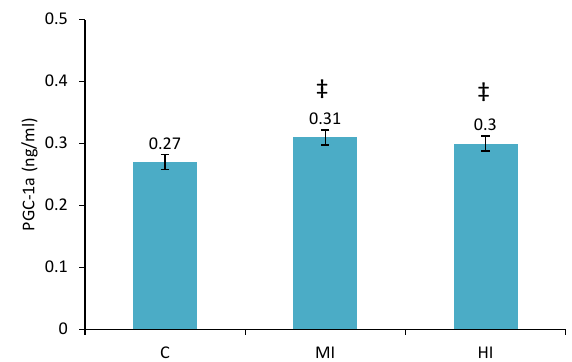
Figure 1. Changes of PGC-1 α levels in different groups. Values are expressed as M±SD. MI: continuous moderate exercise, HI: high- intensity aerobic exercise, C: control. * P <0.05 vs. baseline ‡ Significant level compared to the control group